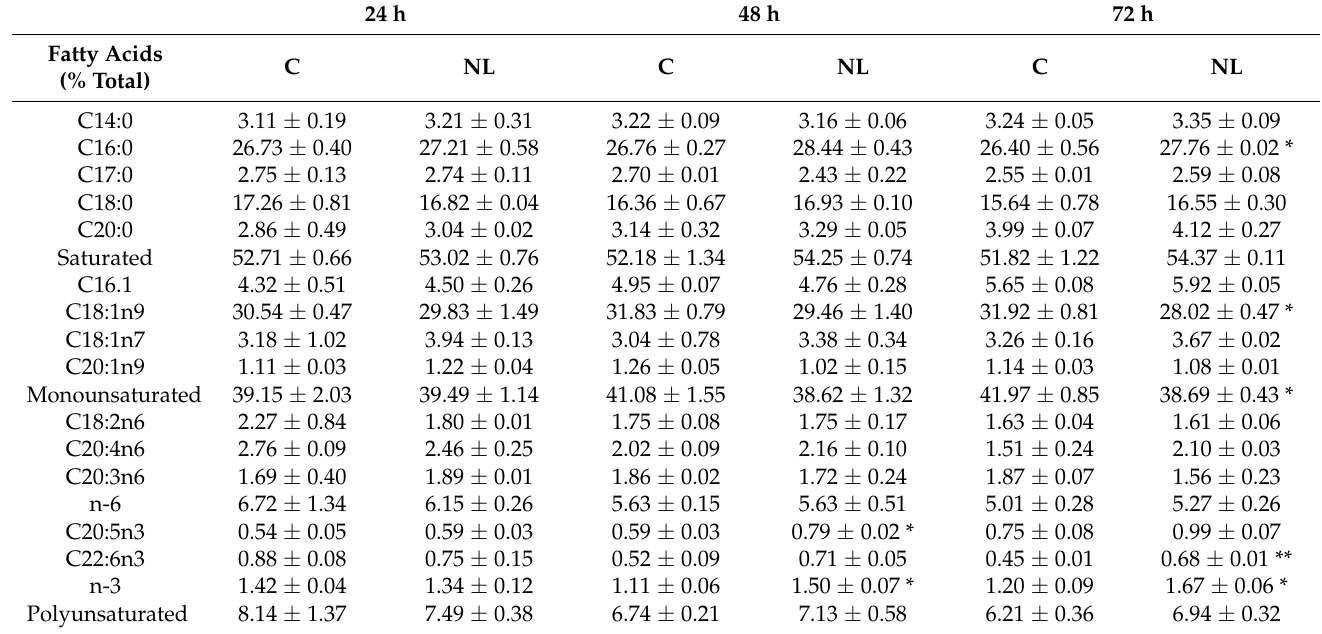
Table 2. Fatty acid composition in primary cultures of embryo cortical neurons treated for 24 h, 48 h and 72 h with nanoliposomes (NL) and in the control group (C). The values are expressed as the mean ± SD. Statistical differences between groups for each fatty acid are shown at each incubation time (* p < 0.05, ** p < 0.01). 24 h 48 h 72